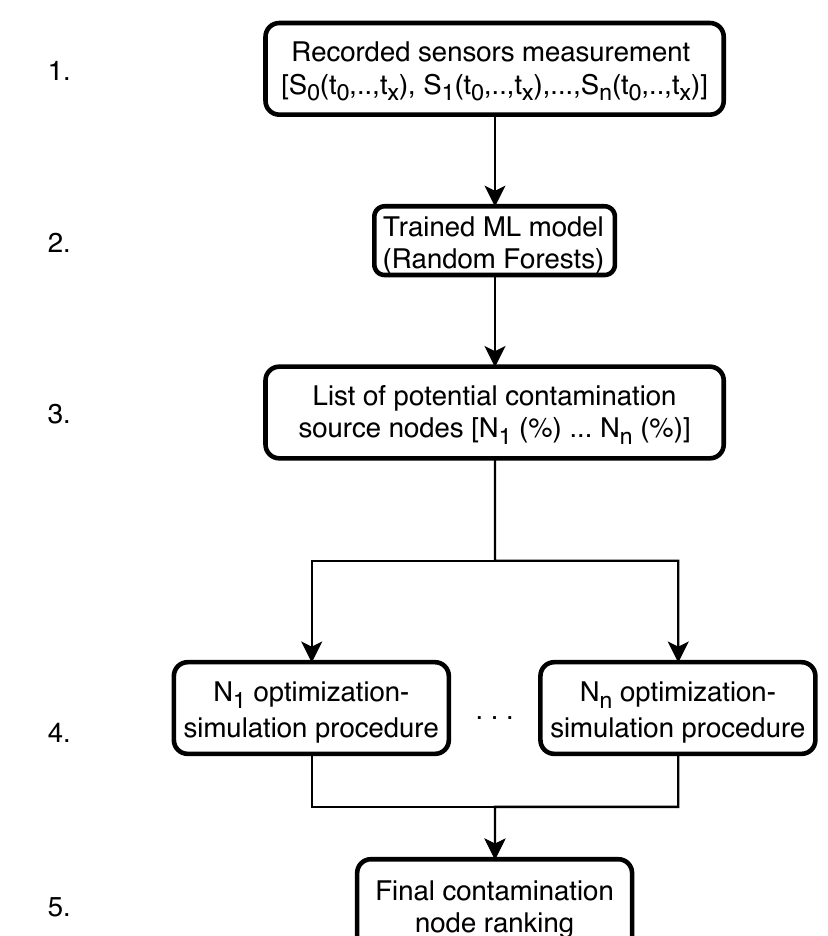
Figure 5. Machine learning and simulation-optimization coupling algorithmic framework 1